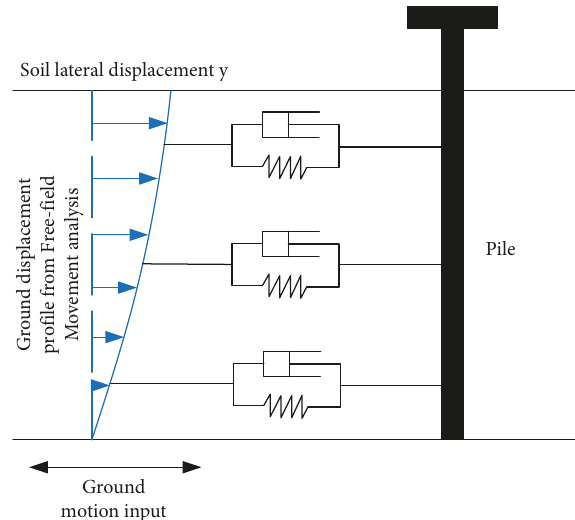
Figure 1: Schematic diagram of p - y curve